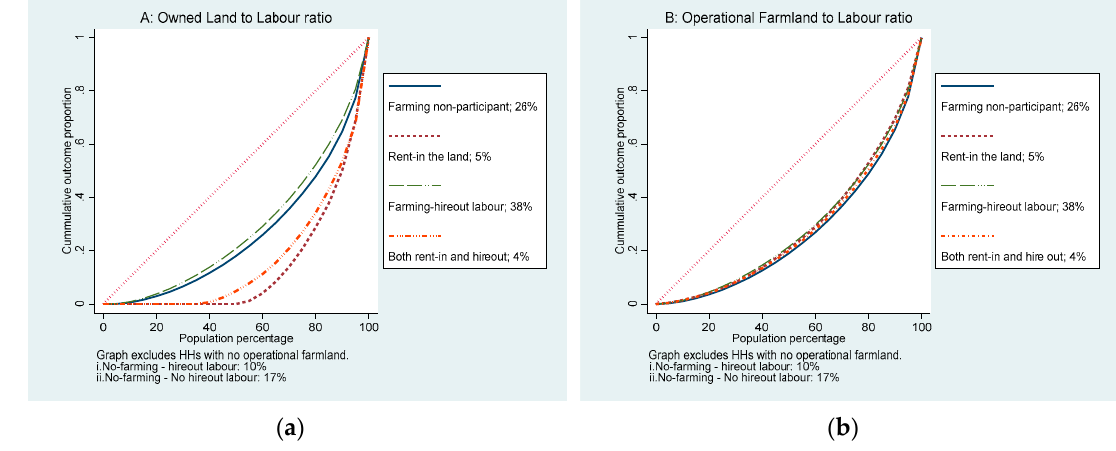
Figure 1. Lorenz curves: ( a ) owned-land-to-labor-endowment ratio; and ( b ) operational-farmland-to labor-endowment ratio. Note: owned land excludes rented, borrowed, or encroached-upon land. Operational or cultivated land includes land from all reported sources at the farm household level. The categories in Table 2 and their respective percentages in the sample are (i) renting-in or